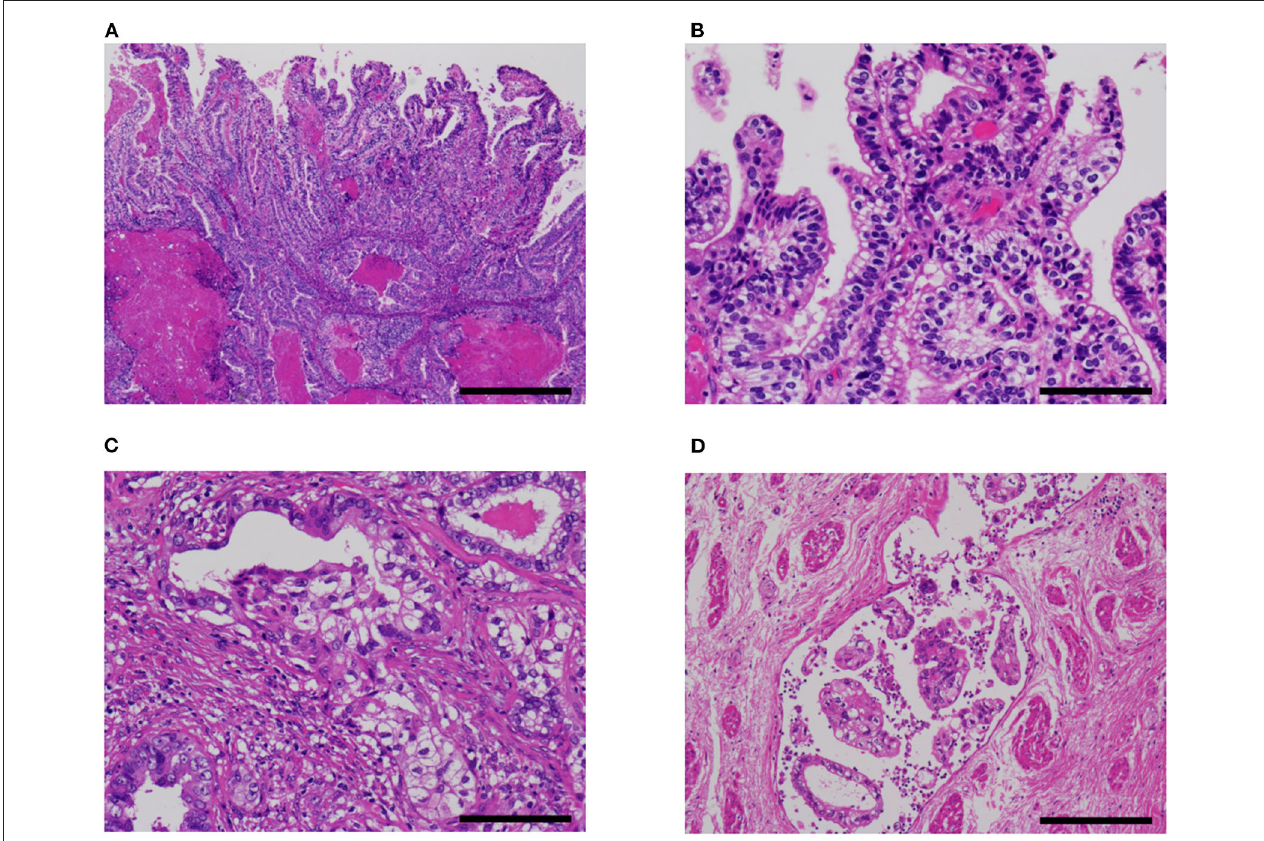
FIGURE 2 | Fetal gut-like pattern of α -fetoprotein-producing endometrial carcinoma (case 5). (A,B) Fetal gut-like pattern was composed of tall columnar neoplastic cells with clear cytoplasms and large nuclei in papillary and glandular architecture. (C) Variable degrees of intraglandular piling-up of neoplastic cells could be seen and imparted clear cell carcinoma-like appearance. (D) In case 5, lymphovascular invasion was extensive. Hematoxylin-eosin; original magnification × 40 (A) , × 200 (B,C) , and × 100 (D) ; 500 (A) , 100 (B,C) , and 200 µ m (D)